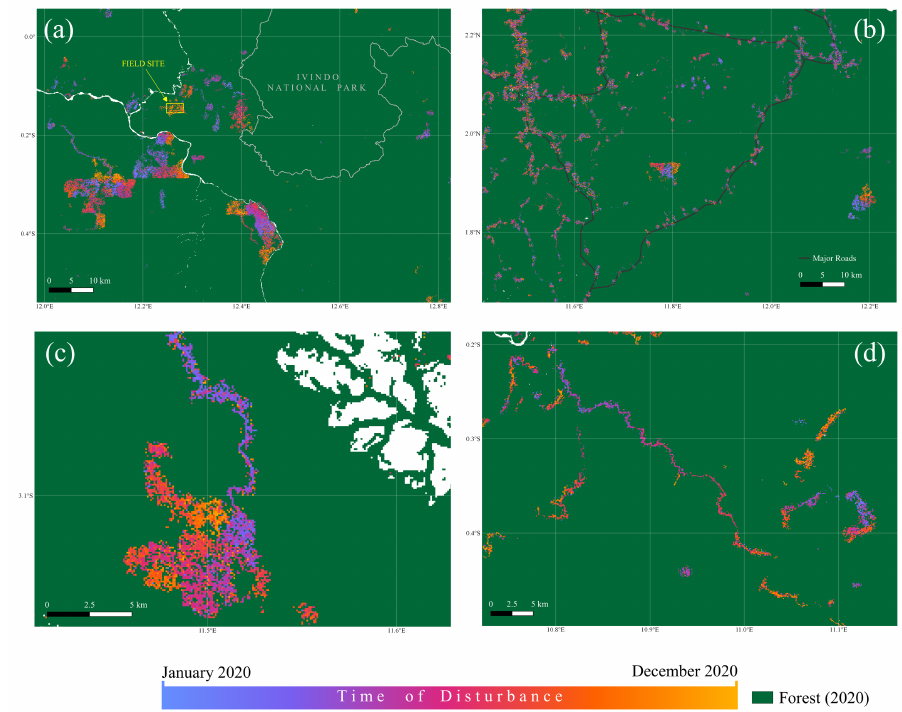
Figure 10. Median time of S-1 detected disturbances within 1-ha pixels for the year 2020. Example ( a ) shows the region surrounding our field site (yellow box) and the boundary with Ivindo National Park (grey line). Example ( b ) shows a more populated area in the north of Gabon where disturbances around the road network (black lines) are more randomly distributed in time. Examples ( c , d ) show clear large scale patterns in disturbance